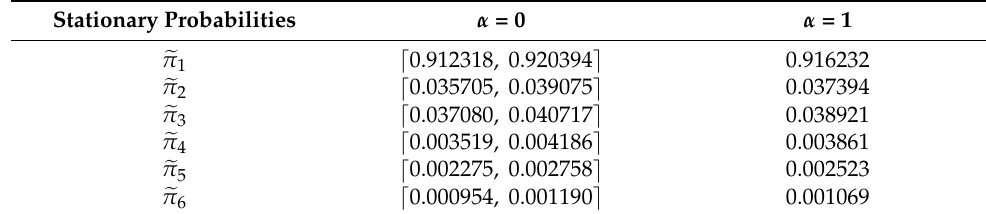
Table 4. Results of the Irish BMS when (cid:101) λ = ( 0.038/0.04/0.042 ) —supports and cores.